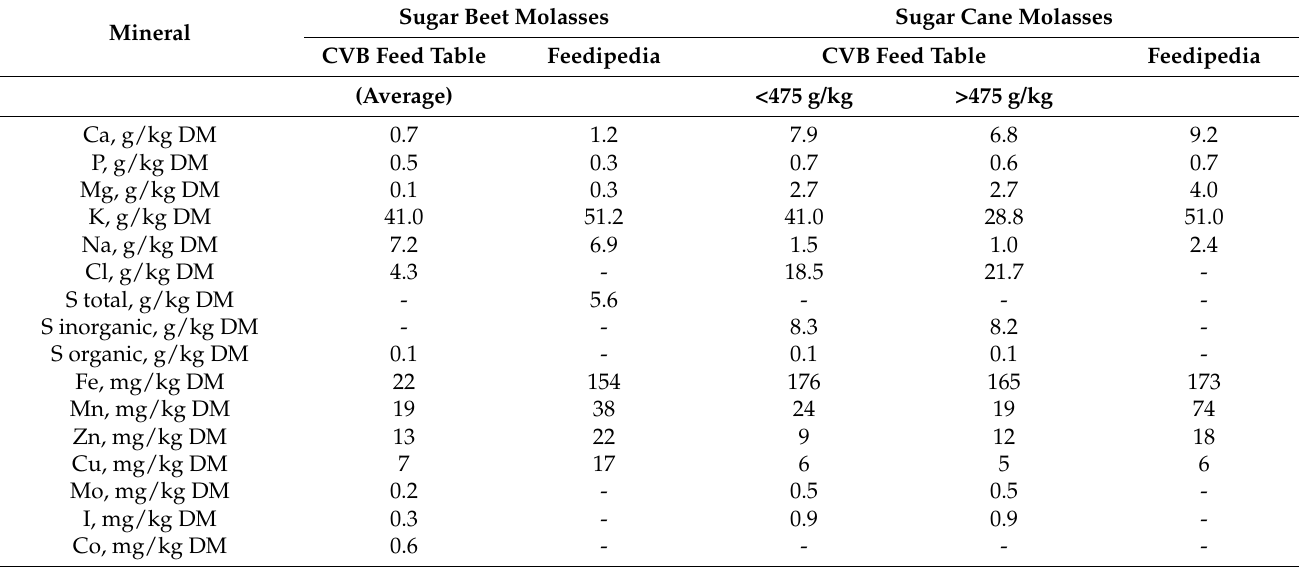
Table 3. Minerals and trace elements contents per kg of sugar beet and sugar cane molasses (modified from the CVB Feed Table 2019. Chemical composition and nutritional values of feedstuffs. www.cvbdiervoeding.nl; and from https: //www.feedipedia.org/).